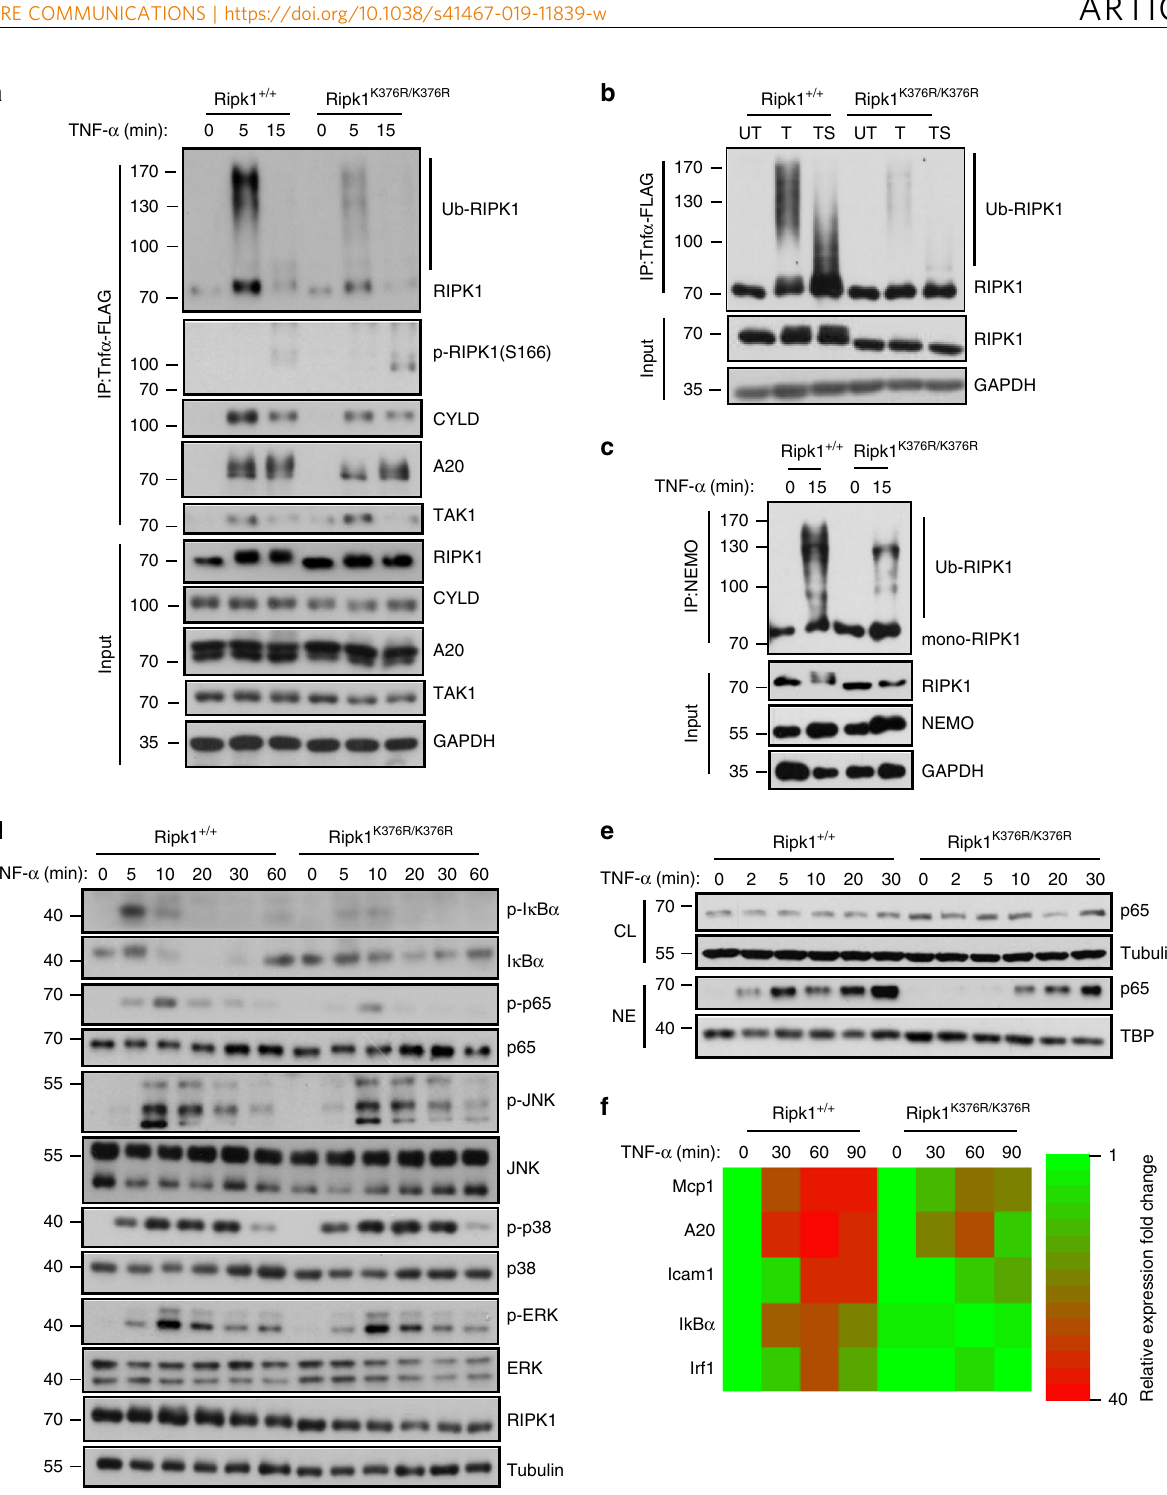
Fig. 2 K376R blocks the ubiquitination of RIPK1 and NF- κ B activation upon TNF- α stimulation. a Ripk1 + / + and Ripk1 K376R/K376R MEFs were treated with Flag- TNF- α (100 ng/ml) for the indicated periods of time, complex I was immnoprecipitated using anti-FLAG beads, endogenous RIPK1 ubiquitination and indicated proteins were detected by western blotting. b Ripk1 + / + and Ripk1 K376R/K376R MEFs were stimulated by Flag-TNF- α (100 ng/ml) for 5 min with or without pretreatment of Smac mimetics, complex I was immunoprecipitated using anti-FLAG beads, endogenous RIPK1 ubiquitination were detected by western blotting. Abbreviations are as follows: T Flag-TNF- α stimulation, TS Flag-TNF- α stimulation with Smac mimetics pretreatment. c Ripk1 + / + and Ripk1 K376R/K376R MEFs were treated with TNF- α (100 ng/ml) for 15 min and then NEMO was immunoprecipitated. Ubiquitinated RIPK1 was detected with RIP1 antibody. Cell lysates were analyzed by western blotting using the indicated antibodies. d Ripk1 + / + and Ripk1 K376R/K376R MEFs were treated with TNF- α (20 ng/ml) for the indicated periods of time, signaling pathways including NF- κ B, JNKs, p38, and ERKs were examined by western blotting. e Ripk1 + / + and Ripk1 K376R/K376R MEFs were treated with TNF- α (20 ng/ml) for 5 min. P65 nuclear translocation was examined by western blotting. Abbreviations are as follows: NE nuclear extracts, CL cell lysates. f Ripk1 + / + and Ripk1 K376R/K376R MEFs were treated with TNF- α (20 ng/ml) for the indicated times, mRNA transcription change of NF- κ B targeted genes were determined by quantitative PCR